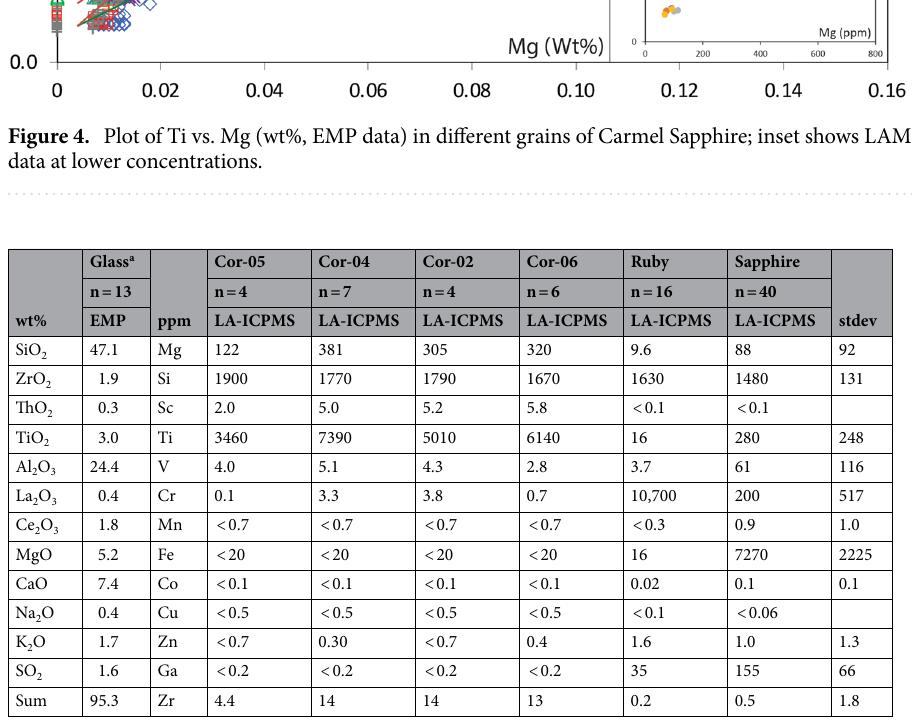
Table 1. Analyses of glass in melt pockets, corundum, ruby and blue sapphire from Mt Carmel. a Mean of analyses of glass with no crystals other than